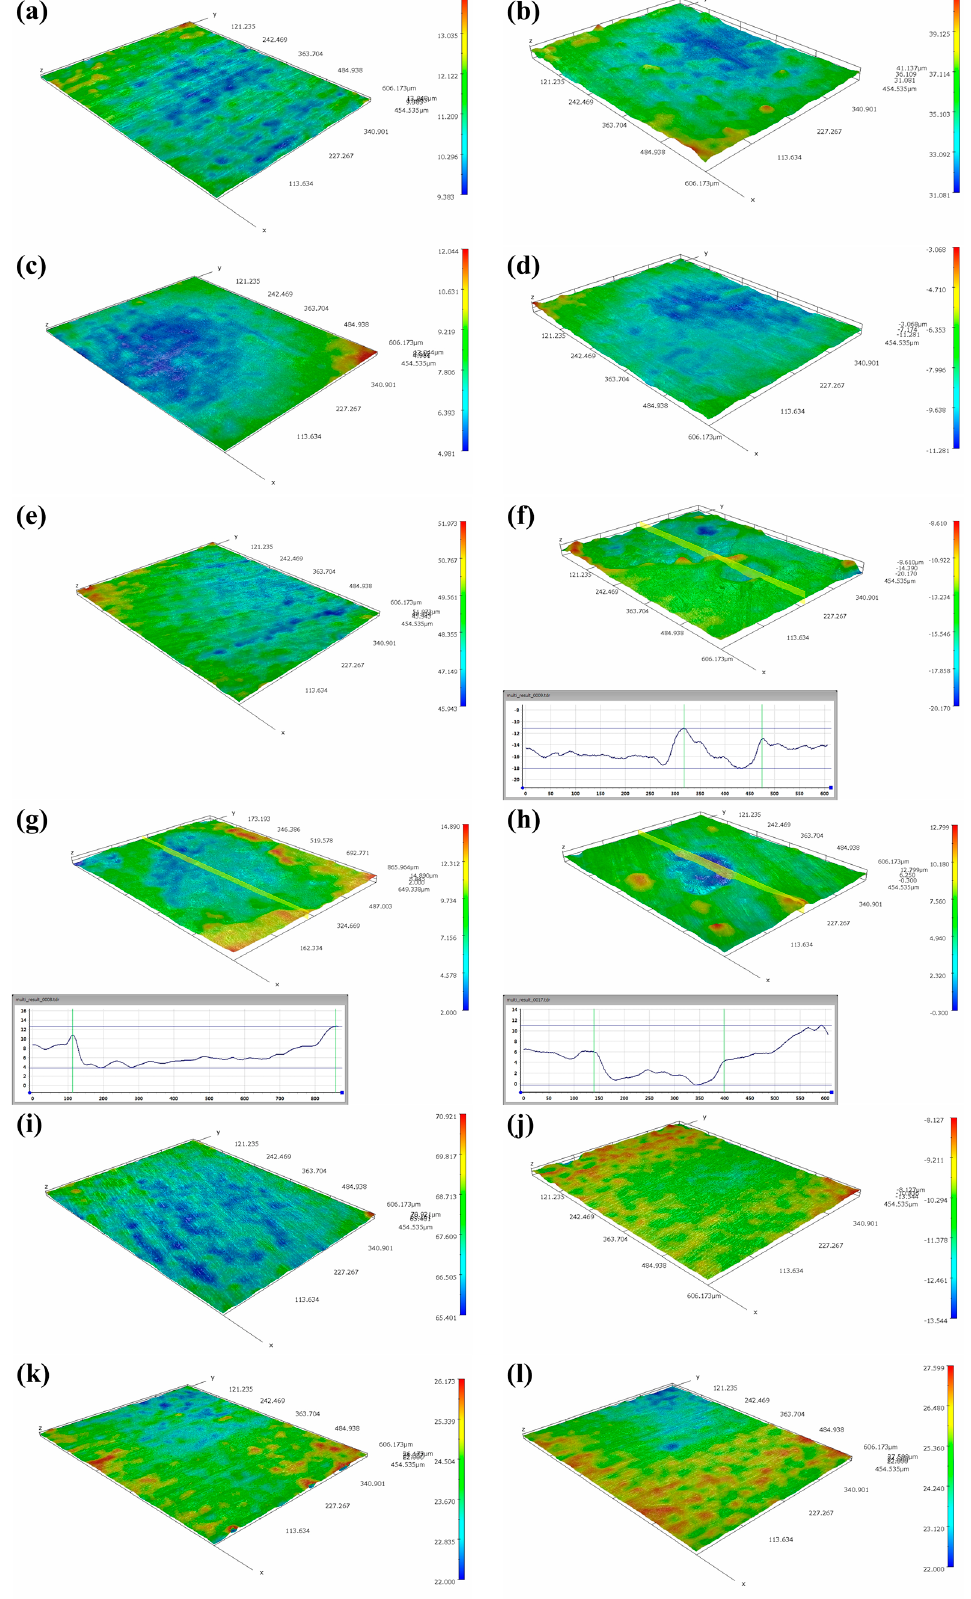
Figure 14. Three-dimensional morphologies of MZ, HAZ and WZ corroded in different flowing rate seawater: ( a , e , i ) 0 m/s, ( b , f , j )1 m/s, ( c , g , k ) 3 m/s, ( d , h , l ) 5 Table 2. Depth of pits of HAZ corroded in different flowing rates of seawater for 30 days. Flowing Rate Static 1 m/s 3 m/s 5 m/s Pit depth/ μ m -